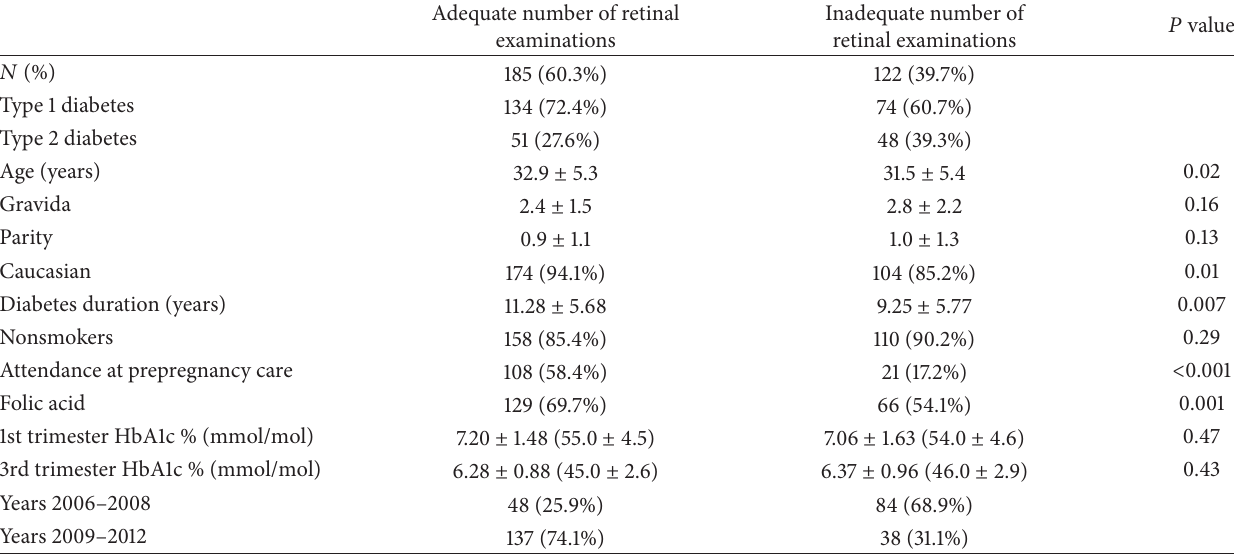
Table 2: Characteristics of women who received an adequate number of retinal examinations versus those who did not ( 𝑛 = 307 ).